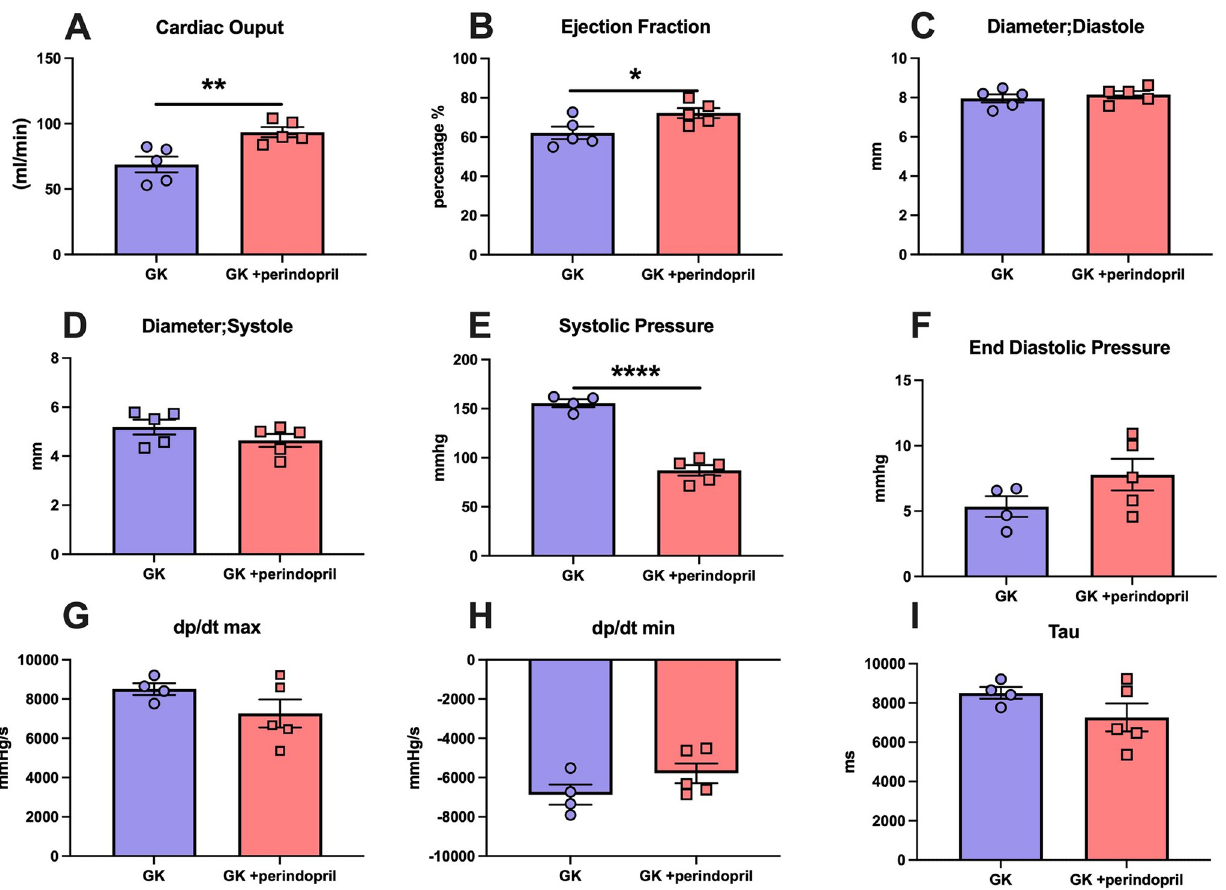
Fig 5. Echocardiographic and cardiac catheterization parameters of GK rats and GK rat treated with Angiotensin Converting enzyme inhibitor perindopril. A-D represents echocardiographic analysis taken from short axis M-mode view demonstrating (A) cardiac output, (B) ejection fraction, (C) diameter in systole and (D) diameter in diastole. E-I represent analysis of cardiac catherization (E) systolic pressure, (F) end diastolic pressure (G) Dp/dt max, (H) Dp/dt min and (I) Tau. All parameters were measured in Goto Kakizaki rats either treated with saline (GK) or ACE inhibitor perindopril (GK + perindopril). Where � = p < 0.05, �� = p < 0.01, ��� = p < 0.001 and ���� = p < 0.0001 when compared to GK rats; (student’s t-test was used to compare groups). Data is expressed as mean ± SEM N = 4–5 per